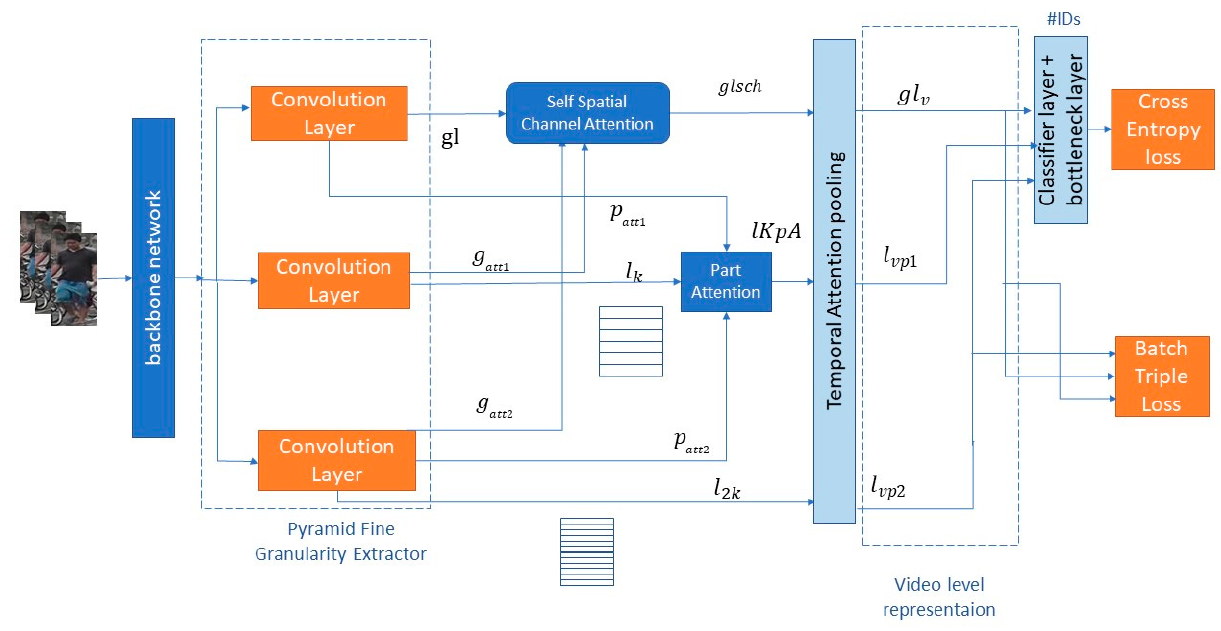
Figure 1. Overall Architecture of the